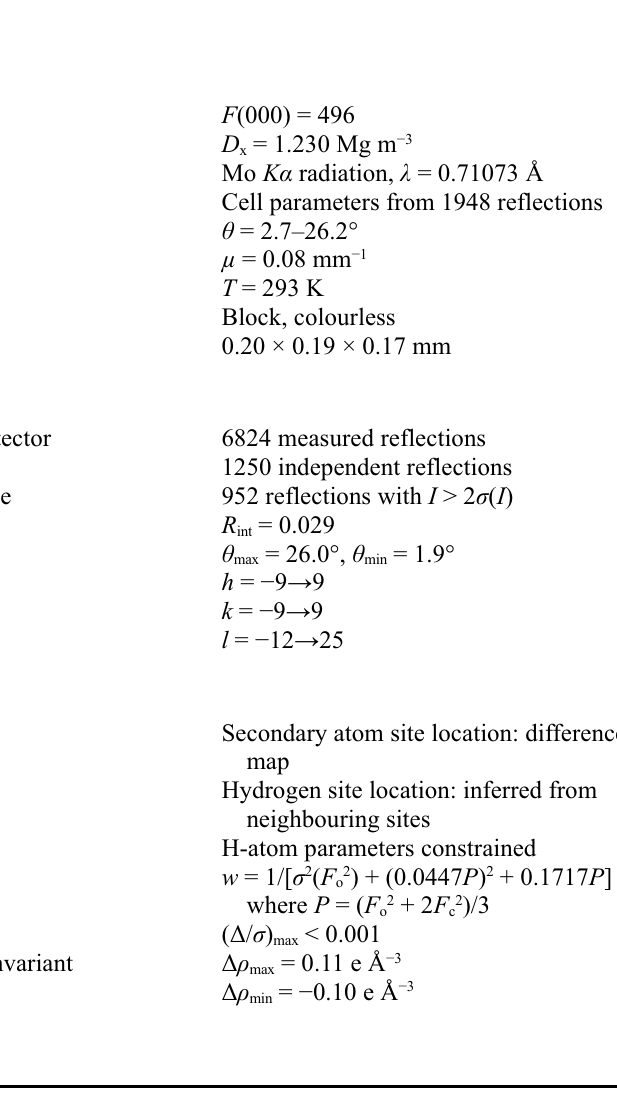
The three-dimensional supramolecular framework of the title complound formed by C—H···O and C—H··· π (arene) hydrogen